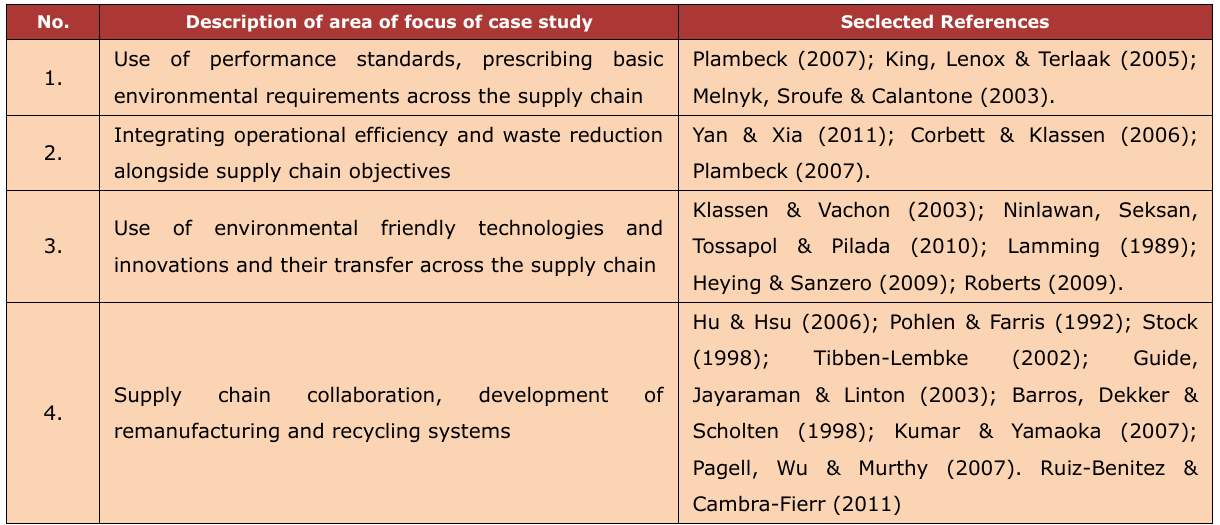
Table 1. An analysis of case studies in GSCM and their main areas of focus Finding 1: Four main areas of focus are environmental performance standards, eco-efficiency, green technology innovations, and collaborative supply chain with remanufacturing and recycling